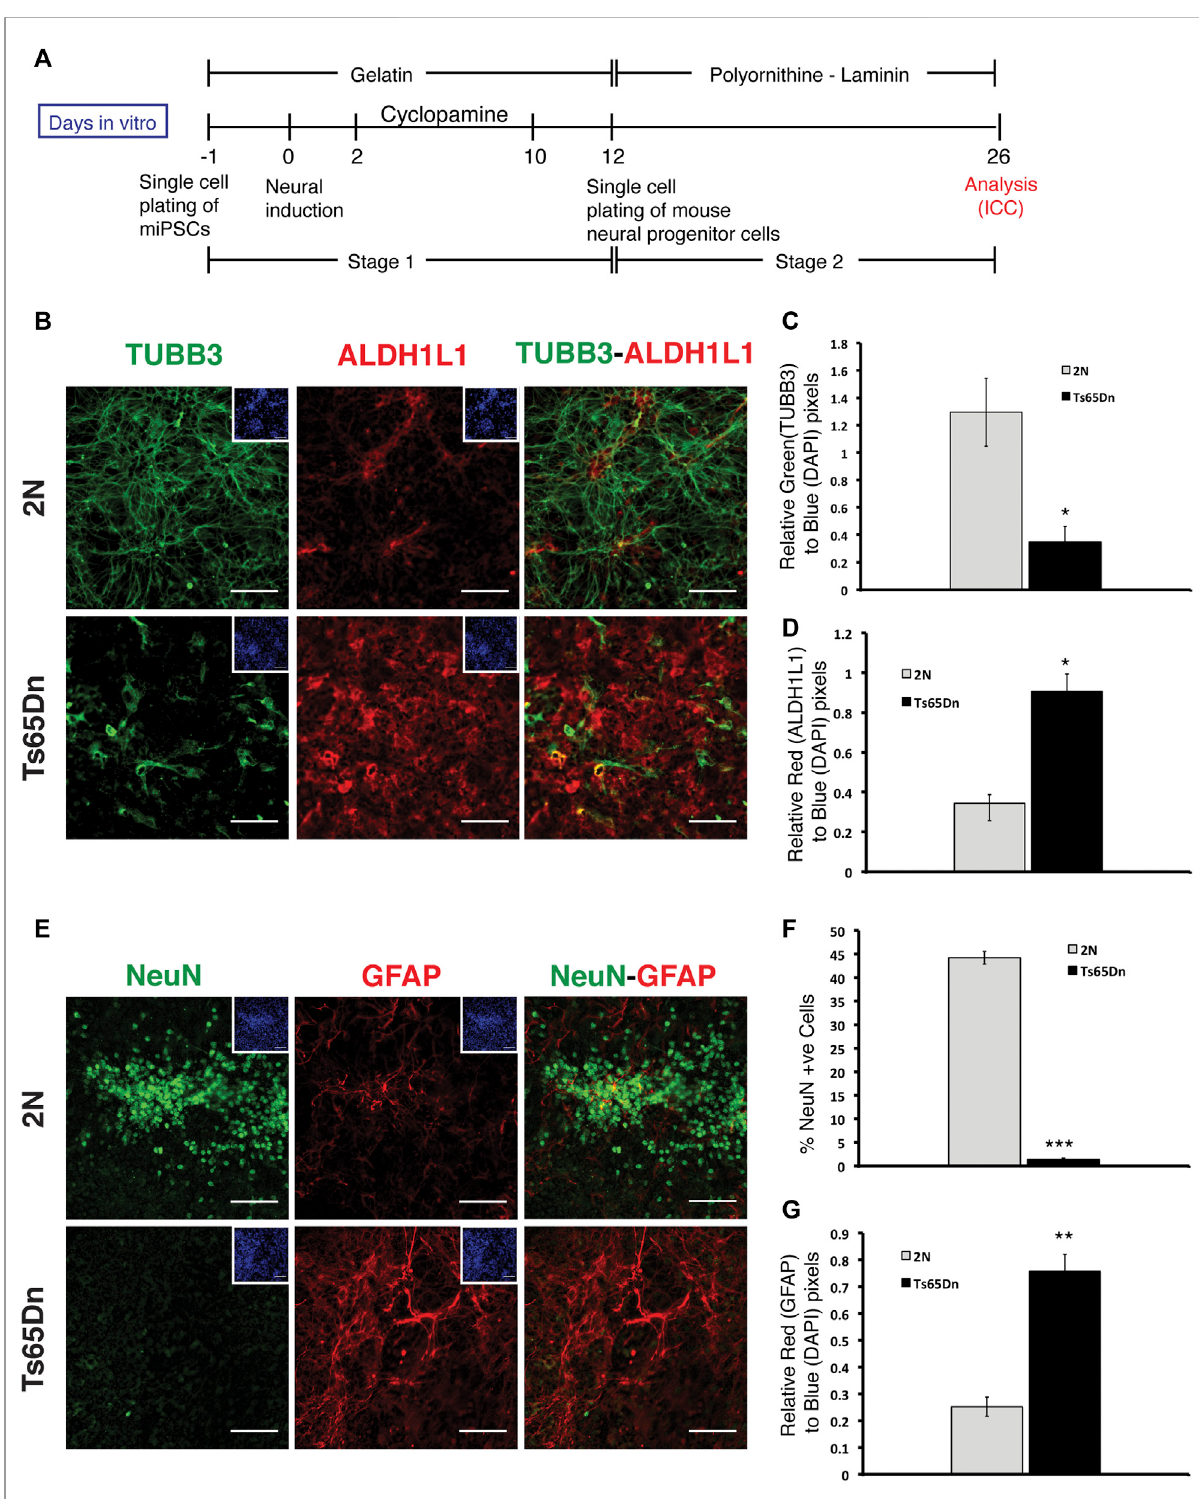
FIGURE 2 Analysis of monolayer-mediated neural differentiation of 2N and Ts65Dn miPSCs. (A) Schematic representation of neural differentiation protocol for miPSCs. Stage 1 is de fi ned as the differentiation of iPSCs to neural progenitors, and stage 2 is de fi ned as the differentiation of neural progenitors to postmitotic neural differentiation. (B) Representative images of TUBB3 (green) and ALDH1L1 (red) expressing cells and overlays of TUBB3andALDH1L1imagesatDIV26.CorrespondingDAPI(blue)imageshavebeenshownasinserts (C) Quanti fi cationofTUBB3expressionin